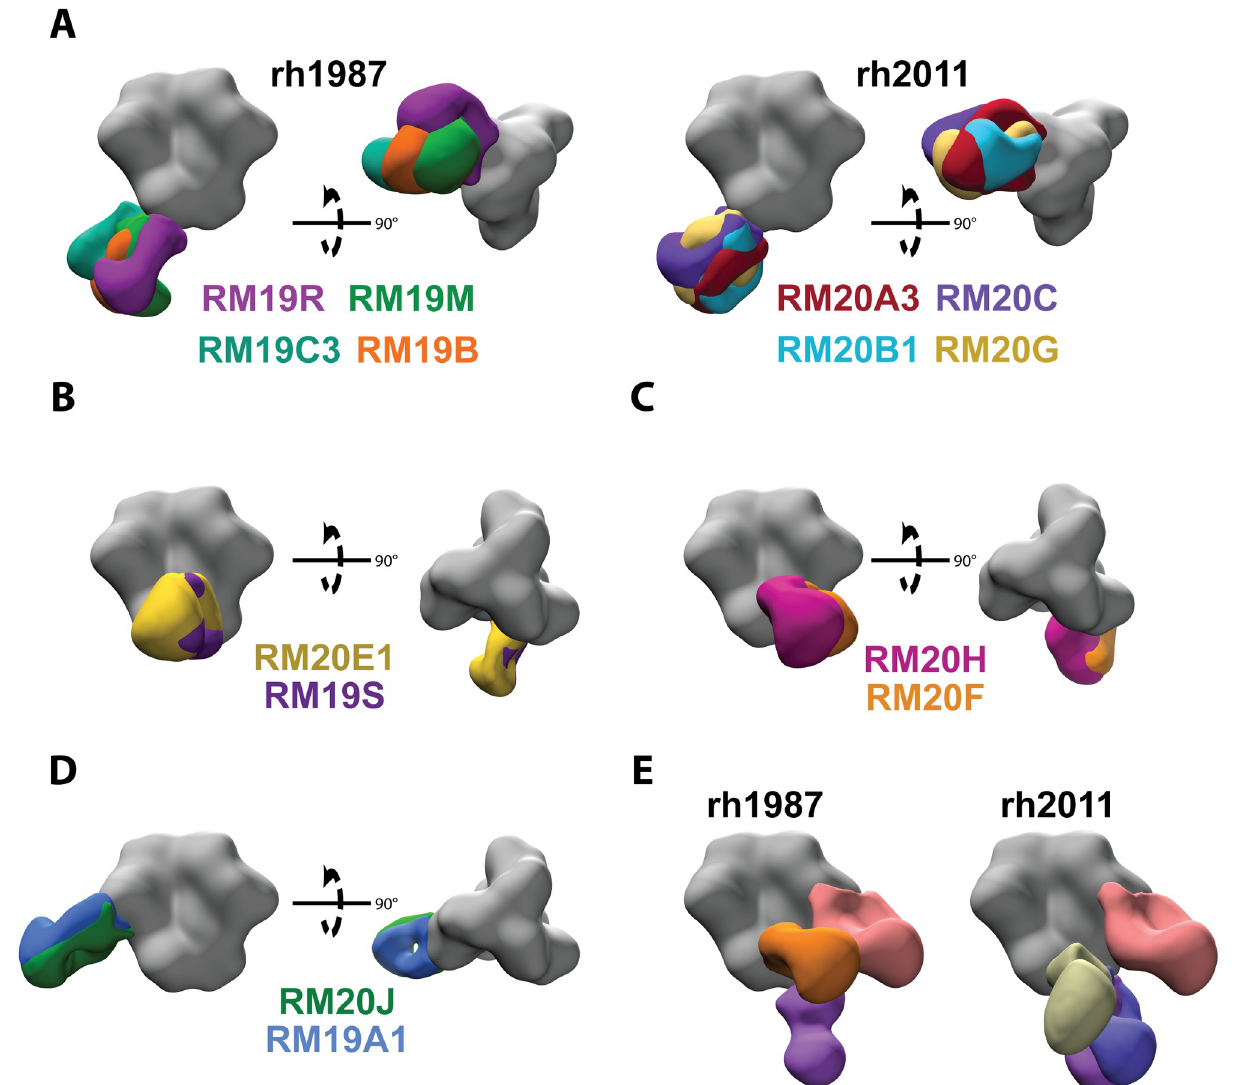
Fig 2. Epitope mapping by negative stain electron microscopy. (A) Representative base-targeting mAbs for animals rh1987 and rh2011. (B) Overlapping gp120/gp41 interface epitope targeted by mAbs from both animals. (C) Overlapping FP epitope targeted by mAbs from both animals. (D) Overlapping N289-glycan hole epitope targeted by mAbs from both animals. (E) EMPEM analysis for wk28 IgG from rh2011 and rh1987. All structural figures were generated with UCSF Chimera [62]. EM density maps were segmented with the Segger extension in UCSF Chimera [62,63].